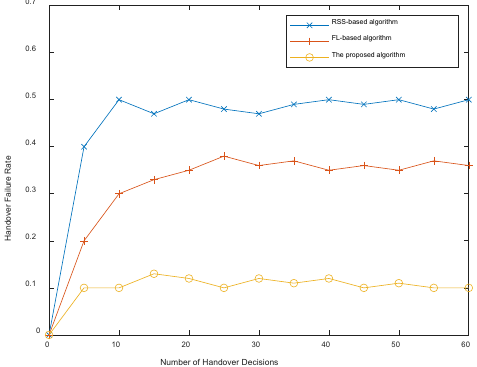
Fig. 9. Handover failure rate versus number of handover decisions.